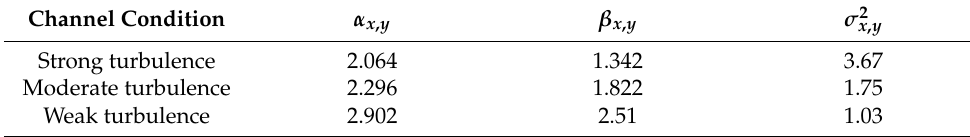
Table 3. FSO sub-channel parameters under different turbulence intensity. Channel Condition α x , y σ 2 x , y Strong turbulence Moderate